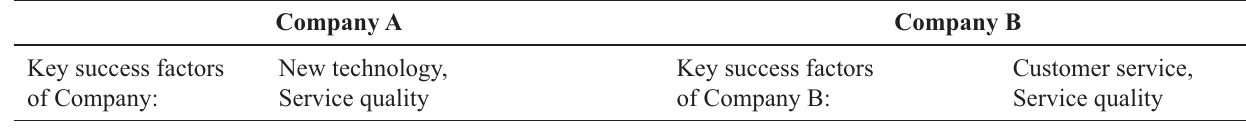
Table 7. Usage of PI by different performance